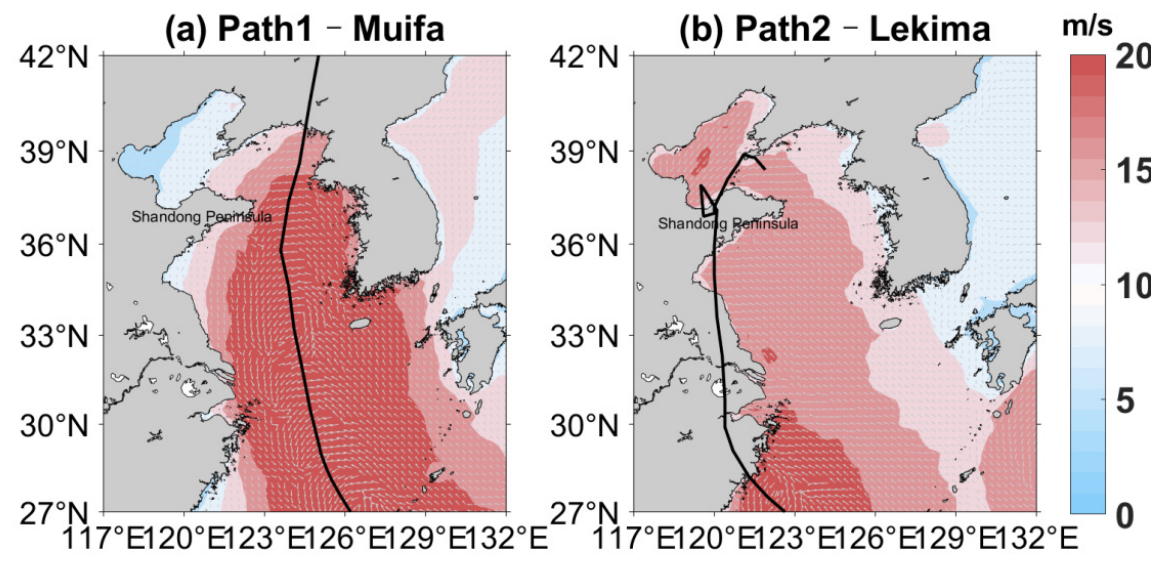
Figure 2. The maximum wind speed field vector diagram of ( a ) Typhoon Muifa and ( b ) Typhoon Lekima over the entire typhoon events.